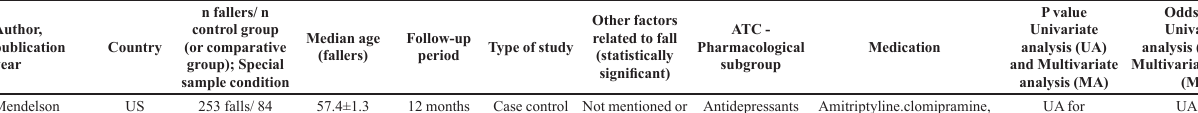
TABLE III - Eligible studies data (cont.)